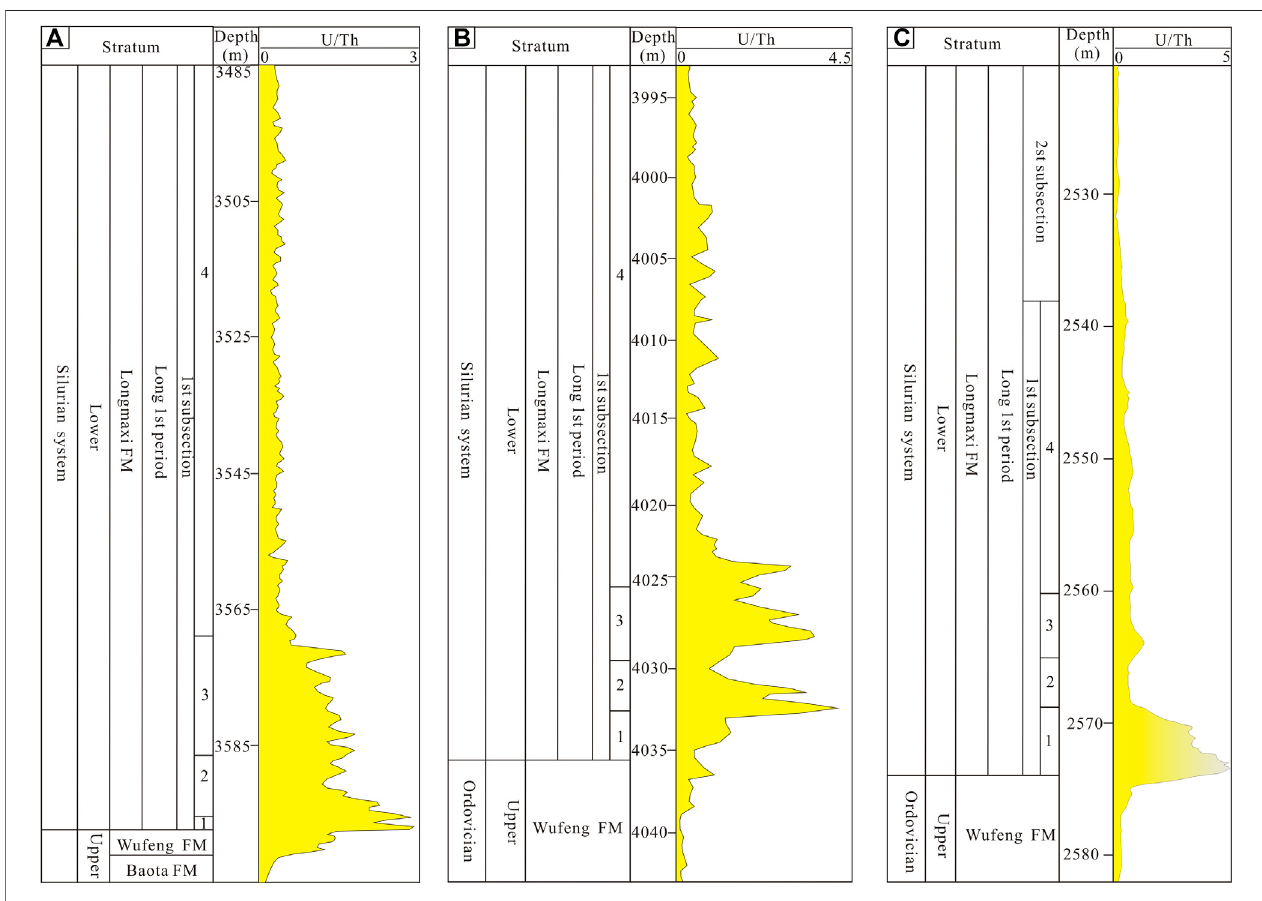
FIGURE2| U/ThcurveofnaturalgammaspectroscopyloggingoftheWufeng-LongmaxiFormationinthesouthernSichuanarea. (A) WellL205intheLuzhouarea, 3,609 m – 3485 m and (B) Well N227 in the Changning area, 4,000 m – 4050 m and (C) Well W202 in the Weiyuan area, 2,530 m-2580 m.